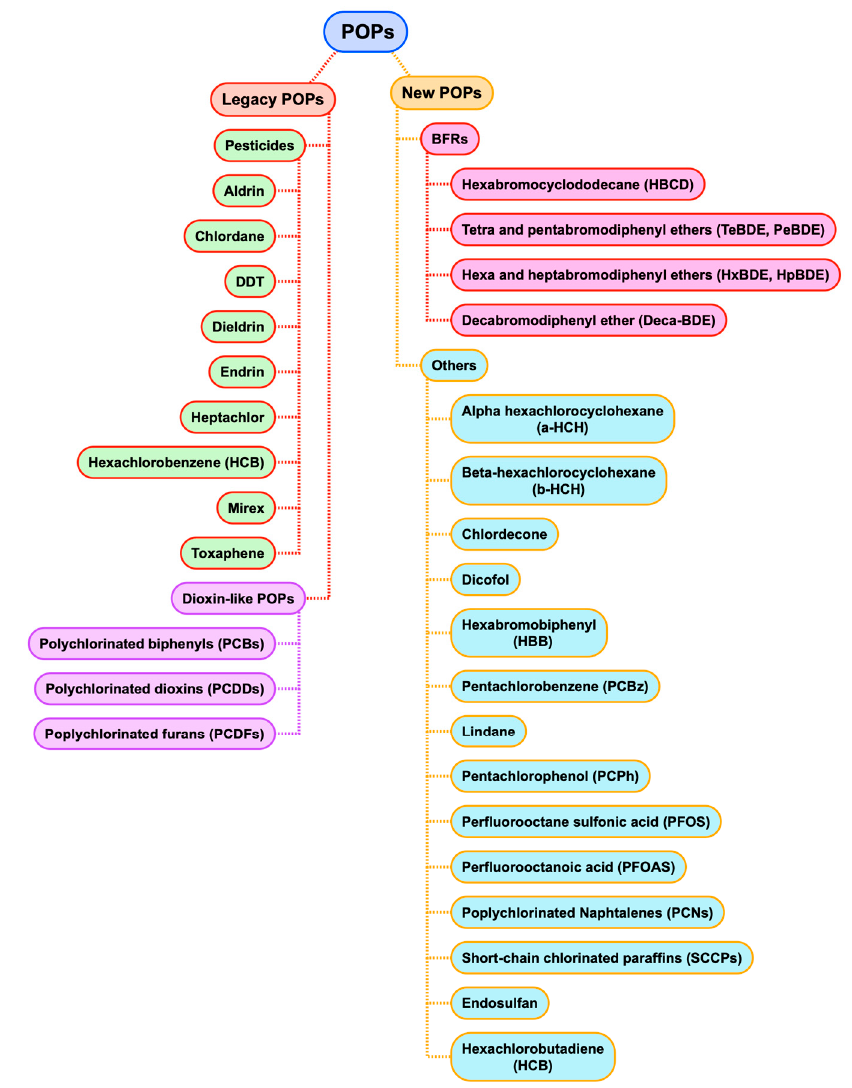
Figure 3. Persistent Organic Pollutants (POPs) considered in the Stockholm Convention.